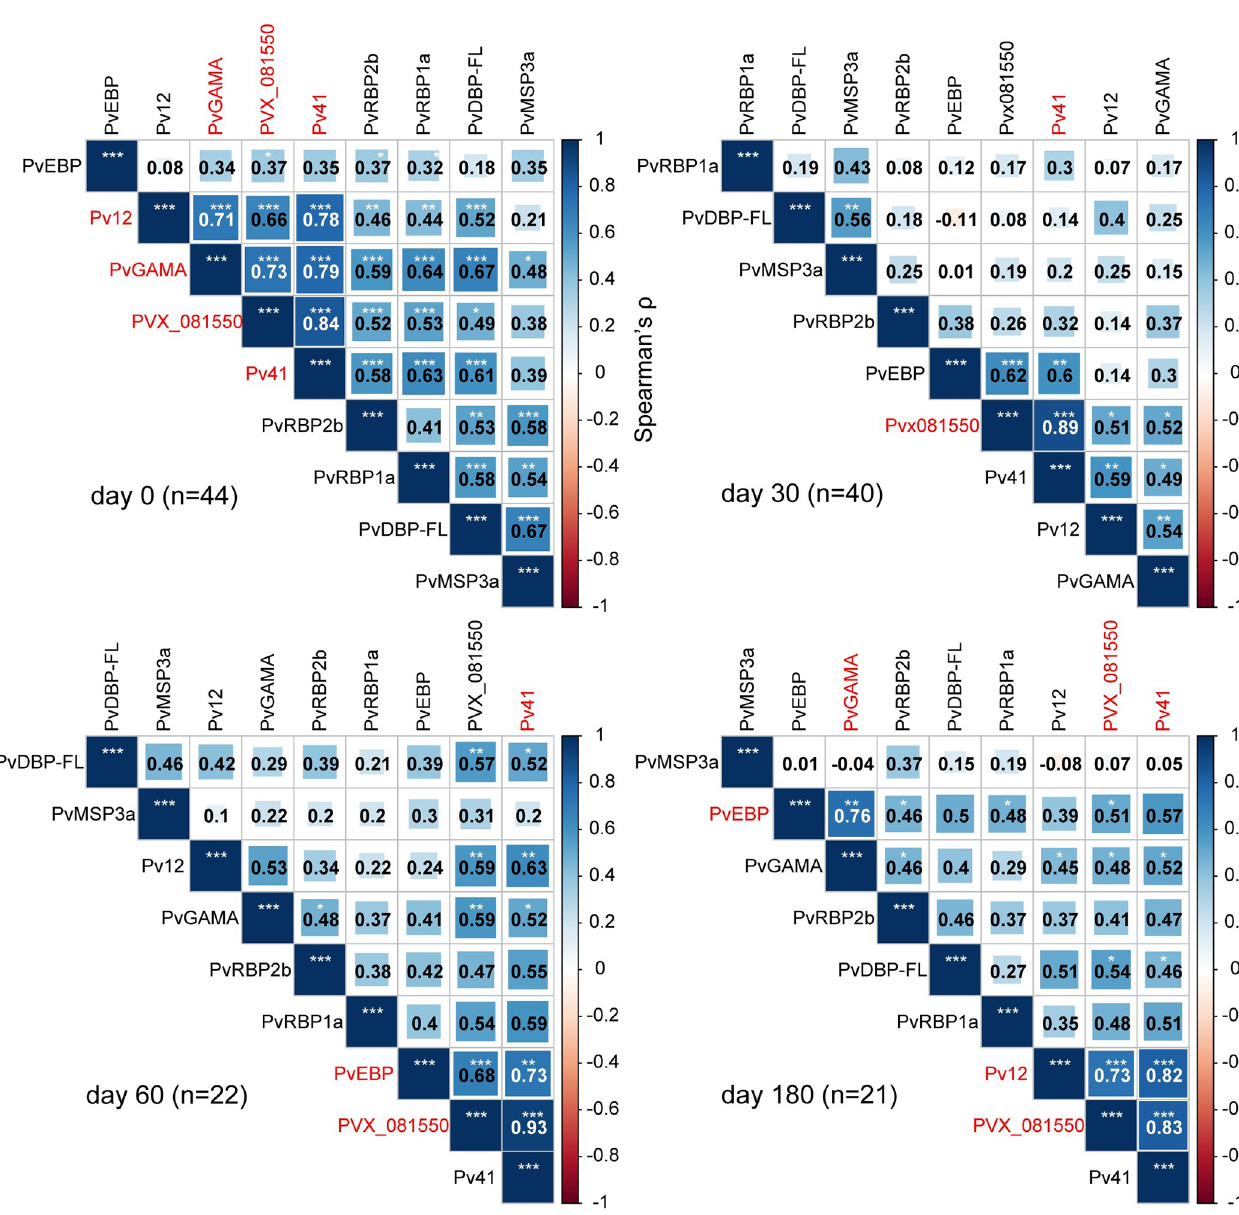
Fig 1. Antibody reactivity correlations between each P . vivax antigen by time point. Pairwise Spearman’s correlations were determined between normalized IgG reactivities for each antigen at day 0 (acute malaria presentation), 30, 60, and 180. Correlation matrices were clustered using the ward.D2 hierarchical agglomerative clustering method. Shown are Spearman’s ρ and significance adjusted for multiple testing using the Holm method. � < 0.05, �� < 0.01, ��� < 0.001 Red text indicates antigen pairs that have a Spearman ρ > 0.70 and adjusted p-value < 0.01, which suggests a strong positive and highly significant correlation. Correlations are inclusive of reactivity data for 9 antigens and all subjects with available plasma at the indicated time points